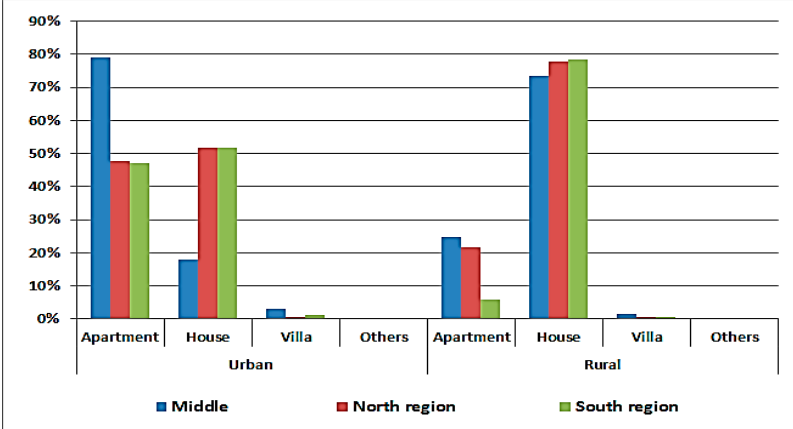
Figure 1. The percentages for each building type in different regions in Jordan in 2008.